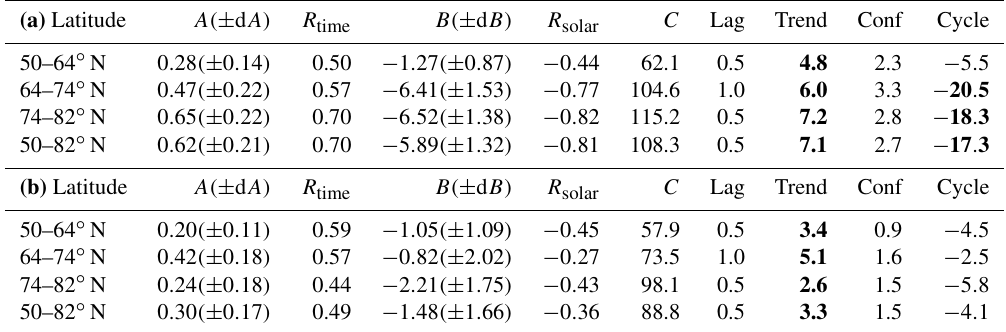
Table 2. (a) Regression fit results for IWC, Northern Hemisphere, 1979–1997. (b) Regression fit results for IWC, Northern Hemisphere, 1998–2018. Bold values exceed the 95% significance of regression fit coefficient.